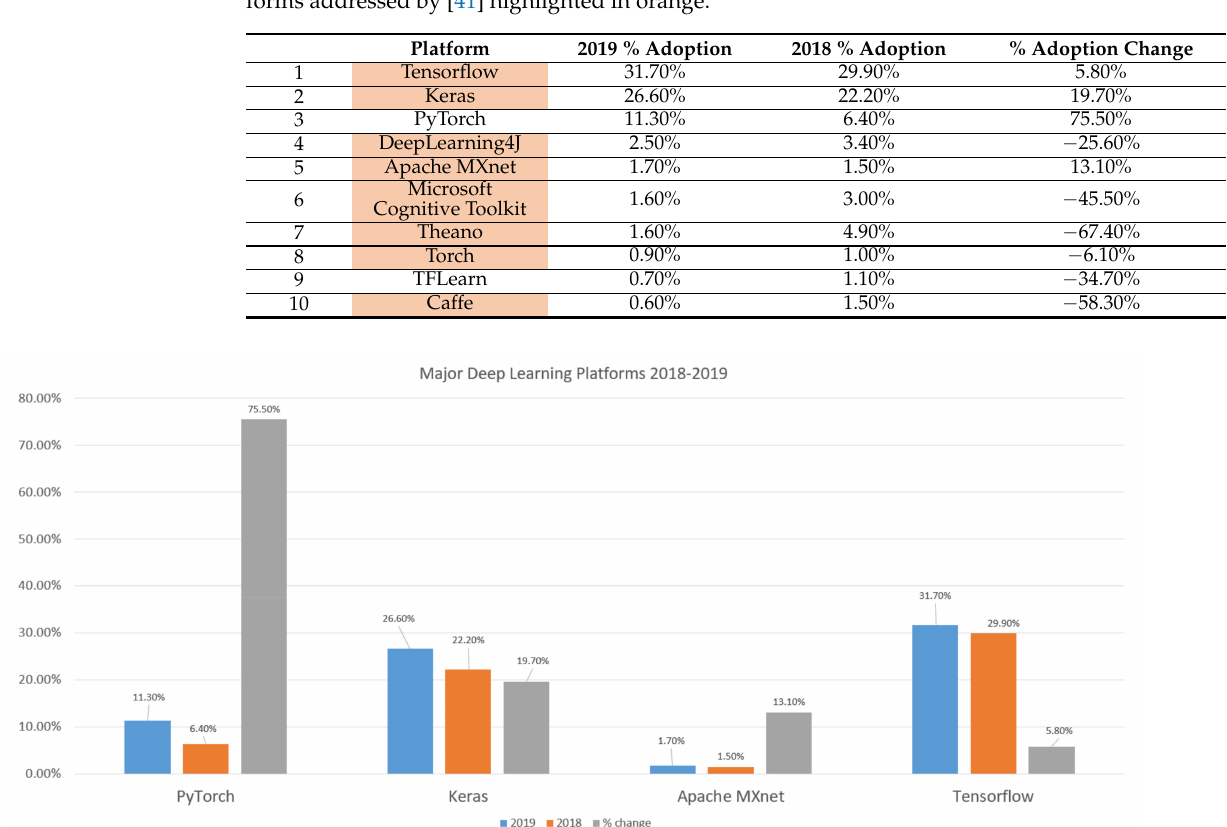
Table 1. Deep learning platforms adoption survey, as conducted by KDnuggets [45,46], with plat- forms addressed by [41] highlighted in orange.